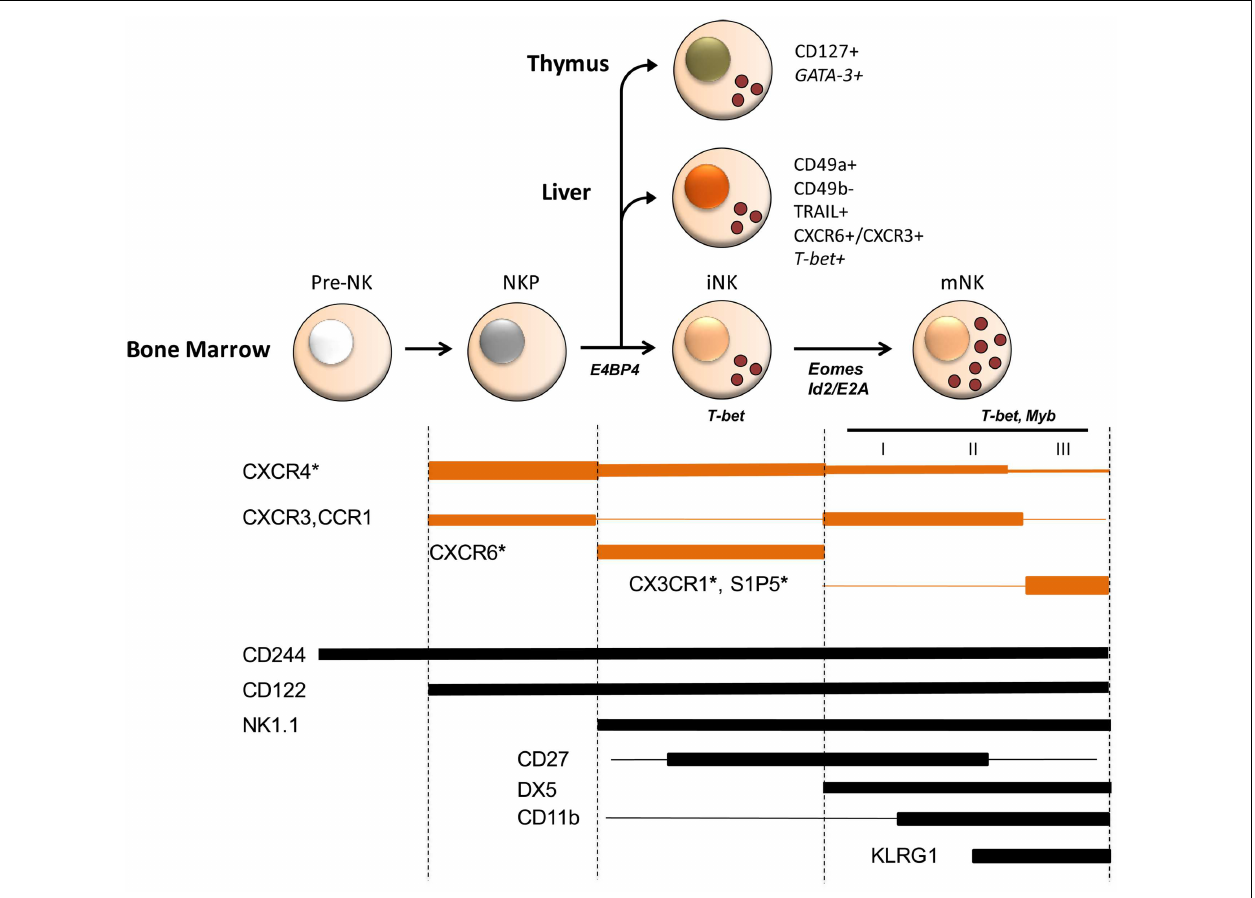
FIGURE 1 | Schematic model of chemoattractant receptor expression during mouse NK cell development and of transcription factors involved in NK cell commitment and maturation . Several stages of differentiation have been defined during which NK cells progressively acquire maturation markers (2–4).Three stages (I–III) corresponding to different levels of functional competence were described in mature CD49b + (DX5 + ) NK cells, being CD27 high CD11b low and CD11b high CD27 high fully competent and a later stage of differentiation marked by the inhibitory receptor KLRG1 having reduced functional capacity. Besides mNK, iNK are found in peripheral tissues, such as liver and thymus, where they represent NK cells with tissue-specific phenotype and functions possibly arising from a BM precursor. Chemokine and S1P receptor expression is developmentally regulated and is